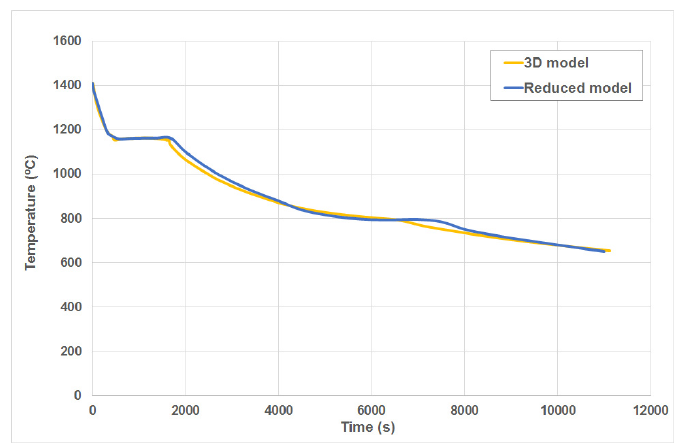
Figure 4. Cooling curve comparison between the pseudo-2D model and the 3D model.